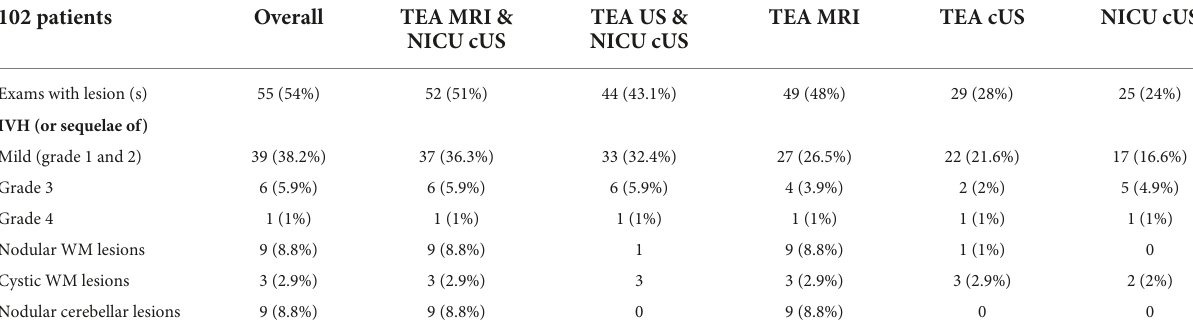
TABLE 2 Qualitative study of brain imaging.